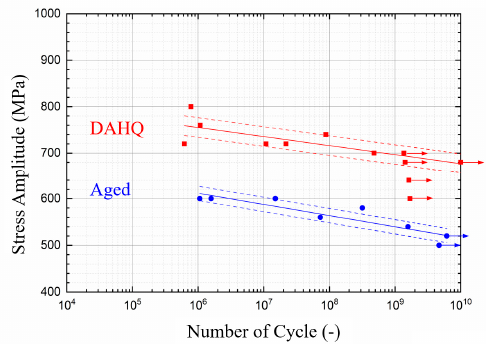
Figure 6. Very high cycle fatigue (VHCF) behavior of Inconel 718 with self-heating ( R = − 1, f = 20 kHz).